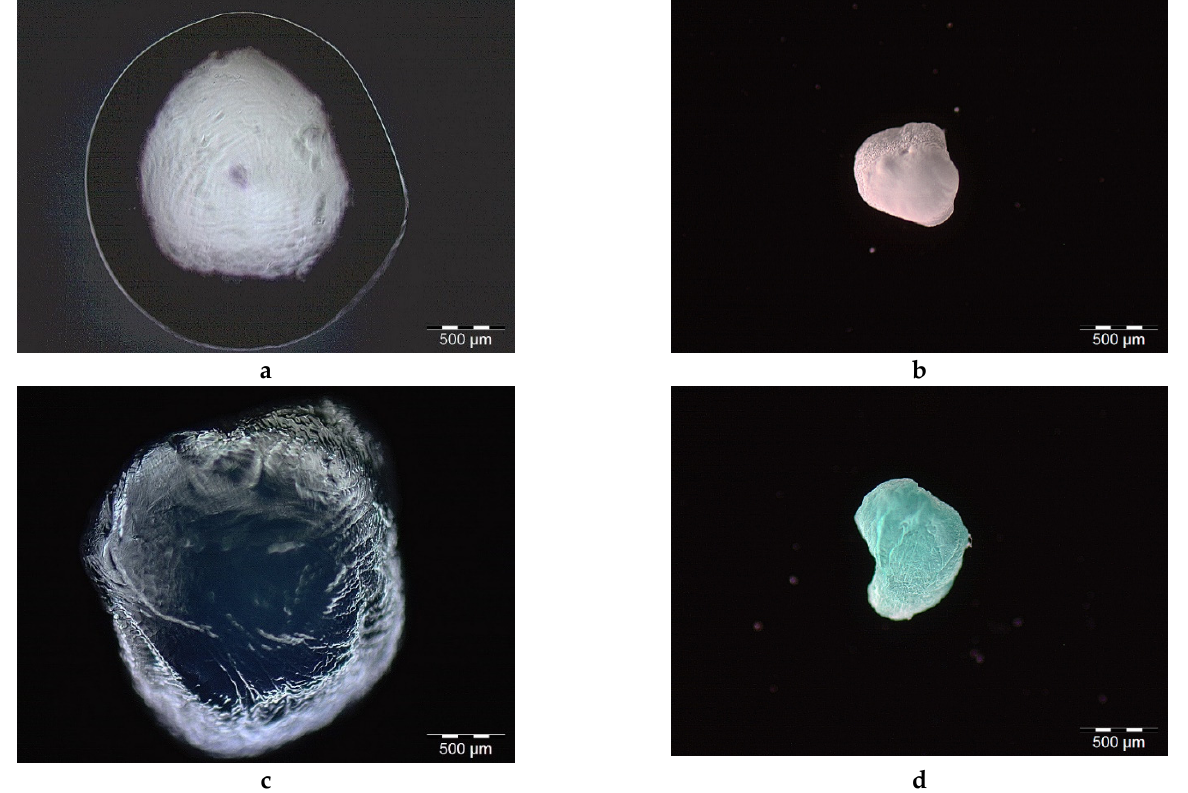
Figure 2. Optical microscope images of wet ( a ) and dried ( b ) CS/(ALG+Ca), and wet ( c ) and dried ( d ) CS/(ALG/(Ca+Cu)) microcapsules. Bars are indicated.